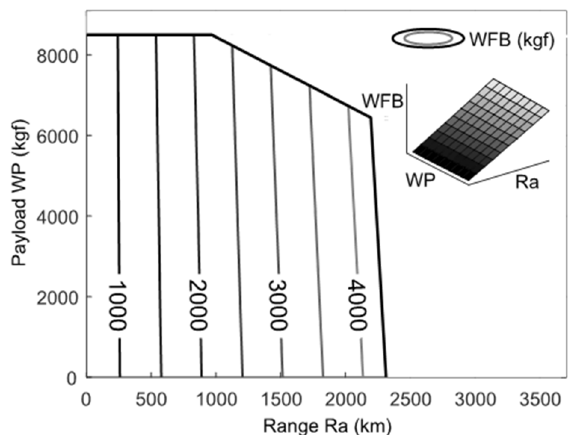
Figure 2. Contours of the Weight of Fuel Burned (WFB) bracketed by the payload-range limitations for an aircraft from the training sample. The top-right thumbnail shows the unbracketed 3D fuel consumption surface.